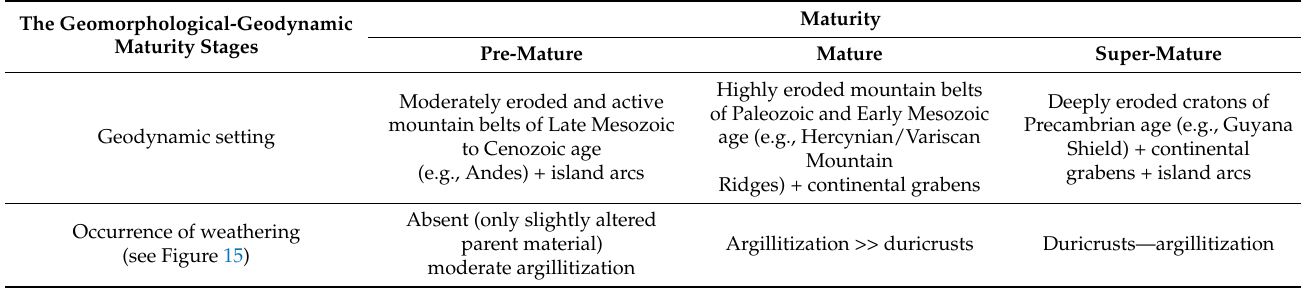
Table 6. Classification scheme of crustal maturity. The mature state is equivalent to the Variscan-type referred to in the current